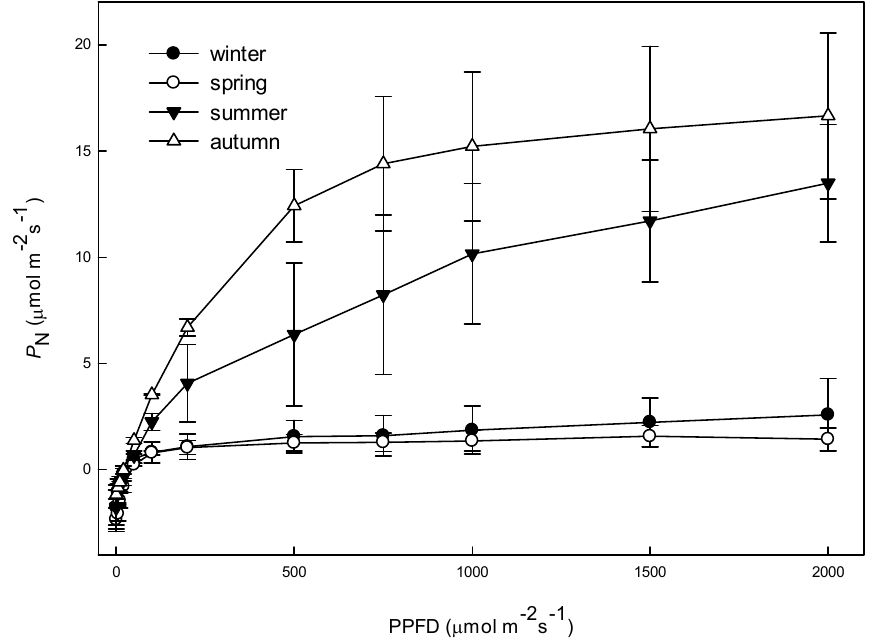
Figure 3. Light response curve of net photosynthetic rate ( P N ) of Fraxinus griffithii across different seasons in 2011. PPFD: photosynthetic photon flux density. Bars indicate ± SE. Table 1. Average values (± standard error) of quantum efficiency ( α ), shape parameter ( θ ), light compensation point (LCP), maximum assimilation rate ( A max ), dark respiration ( R D ), and leaf area index (LAI) of Fraxinus griffithii across different seasons.